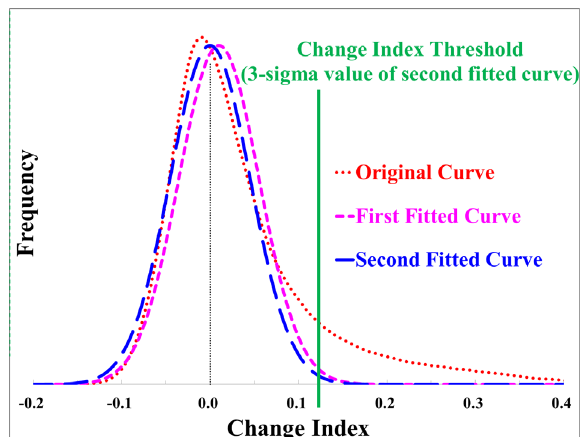
Figure 3. Examples of original, first fitted, and second fitted curves of change index distribution. 3-sigma value indicates triple of standard deviation in second fitted curve.